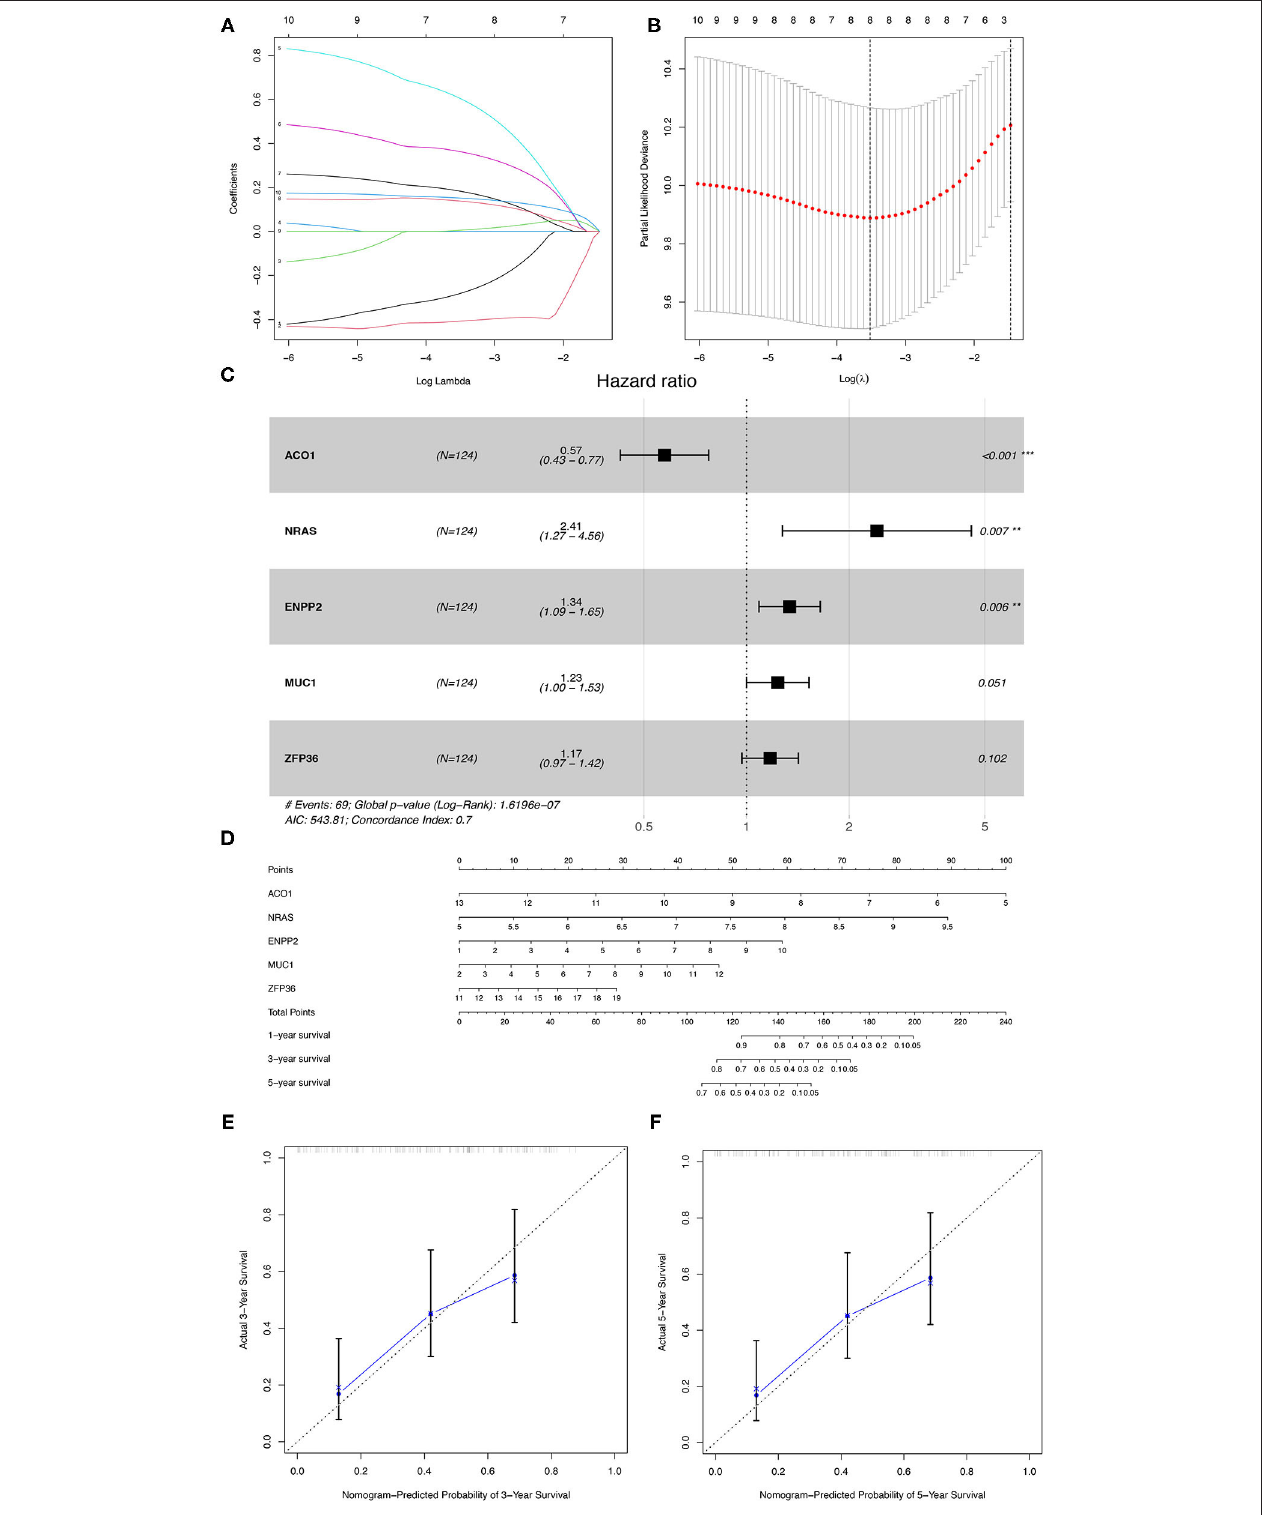
FIGURE 4 | The construction of the prognostic model of IPF in the training group. (A) LASSO coefficients profiles of the 19 overlapping genes. (B) LASSO regression with 10-fold cross-validation obtained eight prognostic FRGs. (C) The multivariate Cox regression analysis identified five prognostic FRGs for prognostic model construction. (D) The nomogram of the prognostic model based on the five FRGs. The calibration curves of the nomogram for predicting 3- (E) and 5-years survival (F) of the patients with IPF. IPF, idiopathic pulmonary fibrosis; FRGs, ferroptosis-related genes. * P < 0.05, ** P < 0.01, *** P < 0.001.